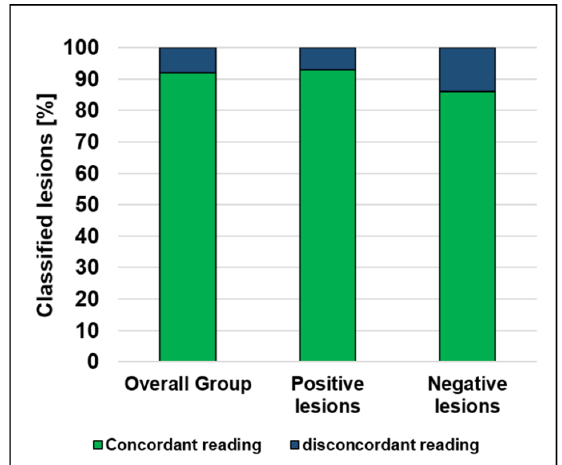
Figure 4. Performance of quantitative reading in direct comparison to standard qualitative clinical